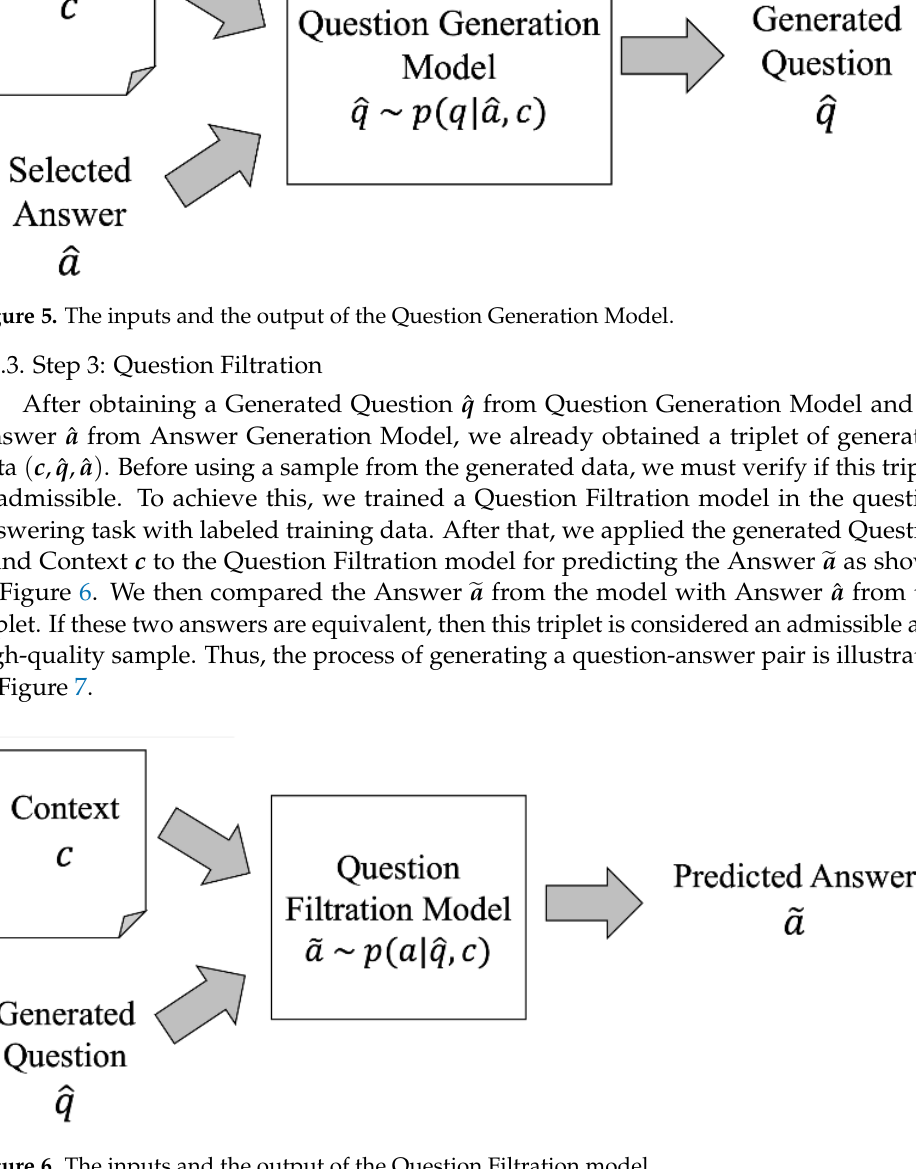
Figure 5. The inputs and the output of the Question Generation Model.